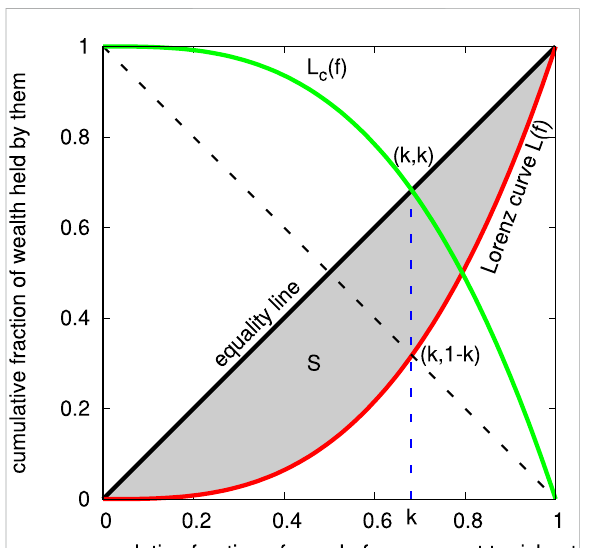
FIGURE 2 Variation of the Kolkata index ( k ) against the Gini index ( g ) for kinetic exchange model with uniform saving propensity ( λ ; CC model). For λ = 0, the estimated values of k ≃ 0.68 and g ≃ 0.5 conform the theoretically estimated exact values of g = 0.5 and k ≃ 0.682, discussed earlier. As expected, with increasing saving propensity, the inequality decreases and g tends to vanish, and k approaches0.5as λ tendstowardsunity.Thesimulationdata fi t well with the relation k = 0.5 + Cg with C ≃ 0.36 (a Landau-like theoryfortheLorenzfunction,discussednext,gives C =3/8).Inset shows the variations of g and k with λ